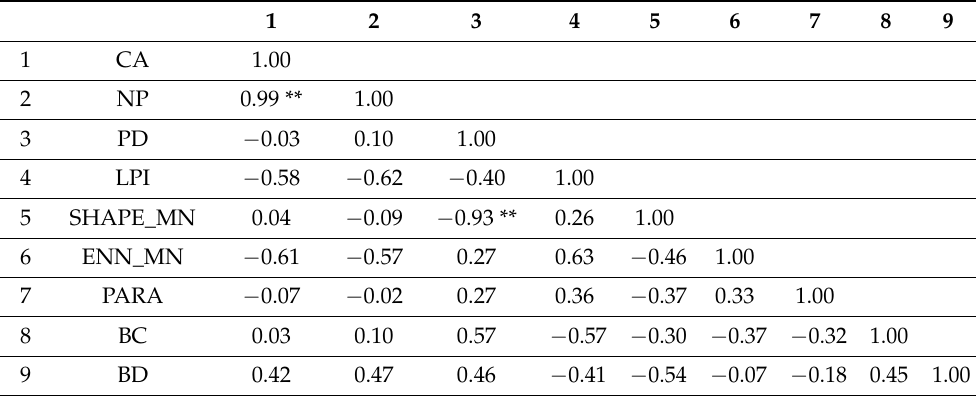
Table 4. Correlations analysis results for landscape metrics and urban form